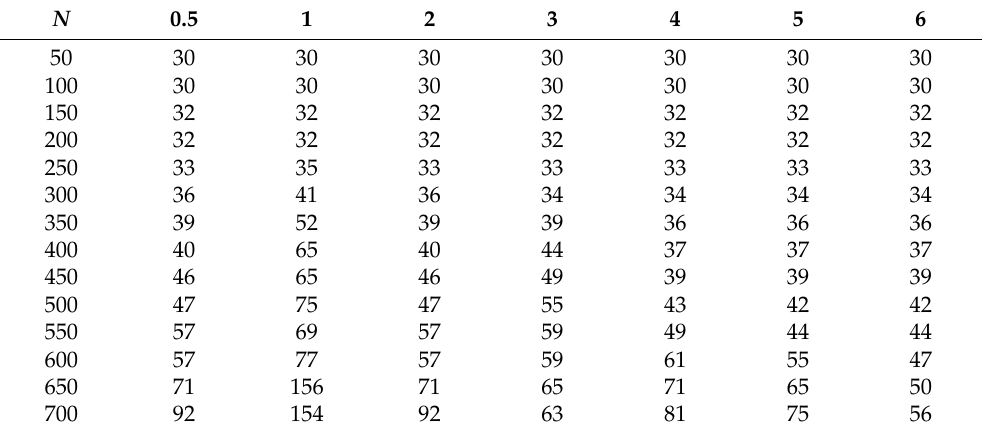
Table 10. The relationship between the number of evacuees and EDRT when D max is different. N 0.5